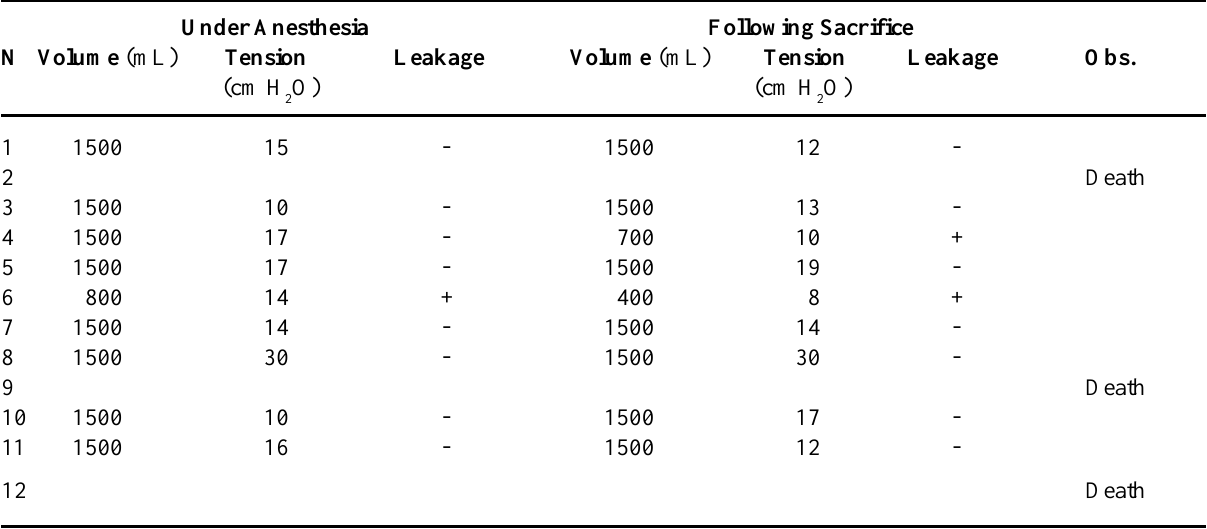
Table 1 – Continence analysis in the study group. The mean infused volume under anesthesia (1422 mL +/- 426) was not different from the infused volume following sacrifice (t = 0.824, p =